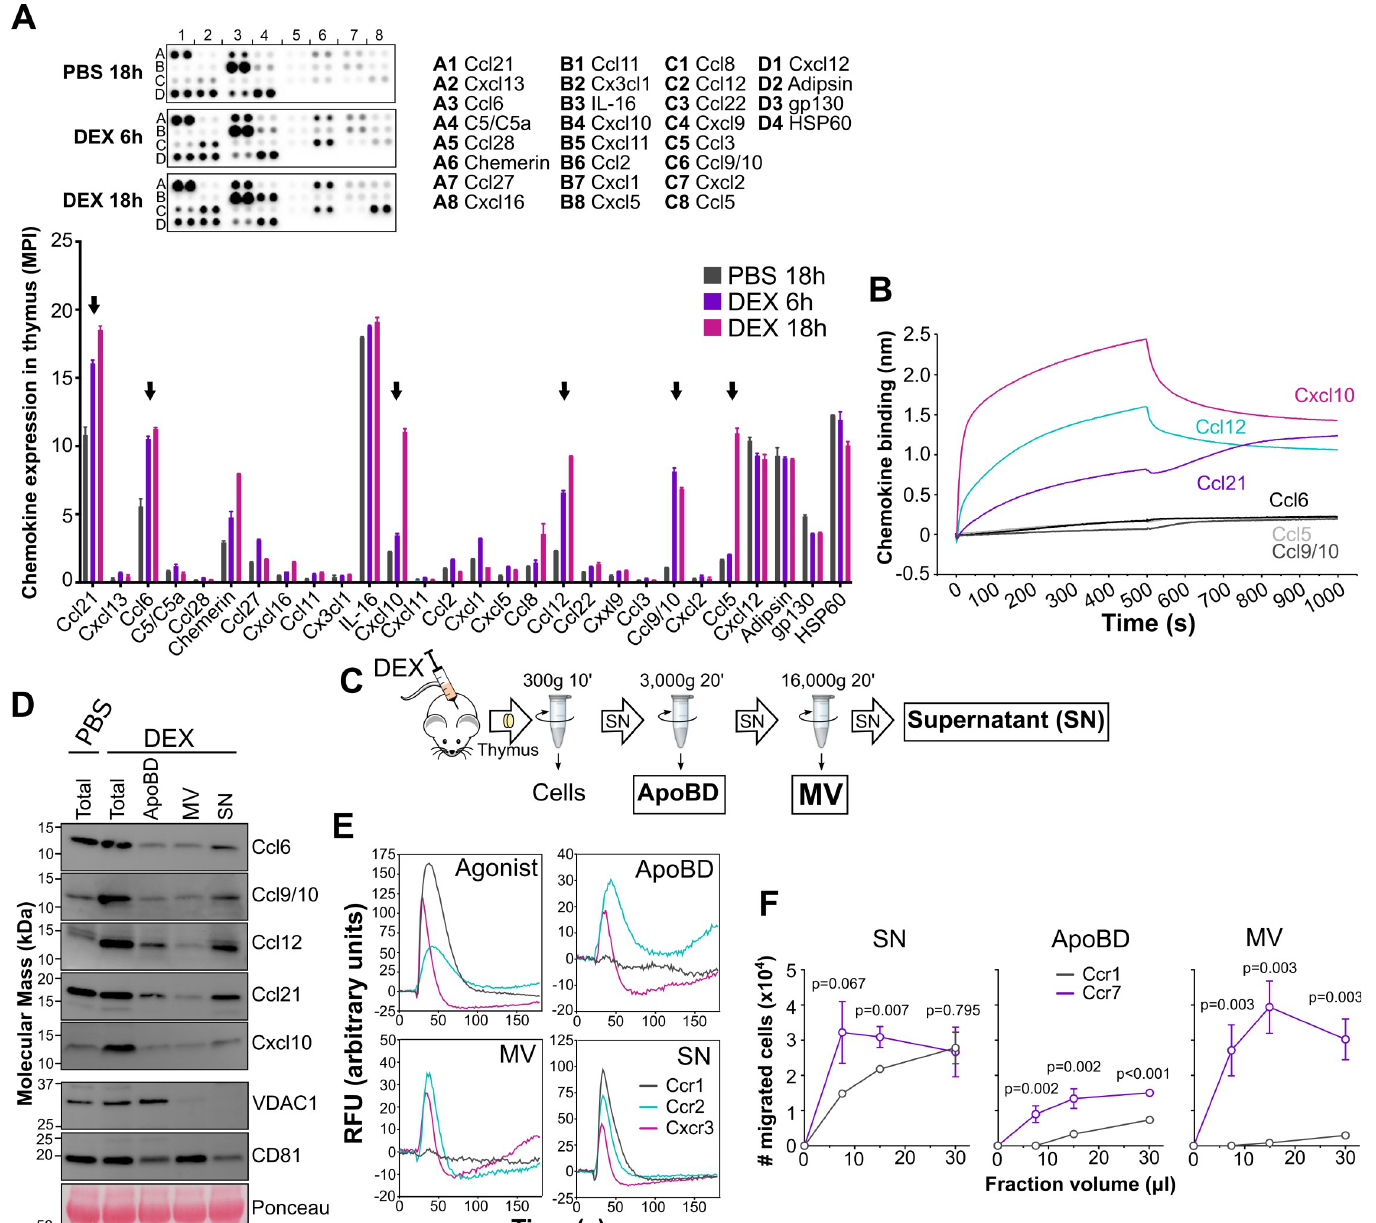
Fig 5. Endogenous PS-binding chemokines presented on the surface of apoptotic blebs in vivo activate cognate GPCRs. (A) Endogenous chemokine expression in the thymus of DEX-treated mice. Top, anti-chemokine antibody array membranes were incubated with 200 μ g of total protein of mouse thymus extracts collected 6 hours or 18 hours after i.p. injection with PBS or DEX. The membranes are spotted in duplicate with capture antibodies for the chemokines indicated on the right side (position coordinates are indicated with lettered rows and numbered columns). Positions D2 (Adipsin), D3 (gp130), and D4 (HSP60) correspond to loading controls. Bottom, mean ± SD of the MPI for each chemokine. Black arrows point to highly DEX-induced chemokines. (B) BLI analysis of the binding of mouse Ccl5, Ccl6, Ccl9/10, Ccl12, Cxcl10, and Ccl21 (500 nM) to DOPS liposomes. Final binding sensorgrams were generated after subtraction of the binding recorded on DOPC sensors used as reference. (C) Schematic representation of the centrifugation steps followed to isolate ApoBDs, MVs, and the final cleared SN from mouse thymus homogenates. (D) Western blot analysis of Ccl6, Ccl9/10, Ccl12, Ccl21, and Cxcl10 and VDAC1 and CD81 as vesicle markers, in ApoBD, MV, and SN fractions isolated from thymus 18 hours after i.p. injection of mice with PBS or DEX. “Total” lane corresponds to the initial cell-free SN. Blot ponceau staining is shown as loading control. (E, F) Functional assays using ApoBD, MV, and SN fractions isolated from mouse thymus 18 hours after i.p. DEX injection. (E) Calcium flux assays using L1.2 reporter cell lines expressing Ccr1, Ccr2, and Cxcr3 (as indicated in the inset of the “SN” panel). The panel labeled “Agonist” shows the calcium flux response after addition of 50 nM of a known recombinant chemokine agonist for each receptor (Ccl9/10 for Ccr1, Ccl12 for Ccr2, and Cxcl10 for Cxcr3). Calcium flux recordings correspond to the mean of duplicates from one experiment representative of 3 independent experiments. (F) Chemotaxis assays using reporter cell lines expressing Ccr1 and Ccr7 (as indicated in the inset of the “ApoBD” panel) and increasing volumes (x-axis) of the indicated fractions. Data are the mean ± SD of the number of migrated cells of triplicates from one experiment representative of 3 independent experiments. p -Values from multiple t tests corrected for multiple comparisons by the Holm–Sidak method are indicated for each volume